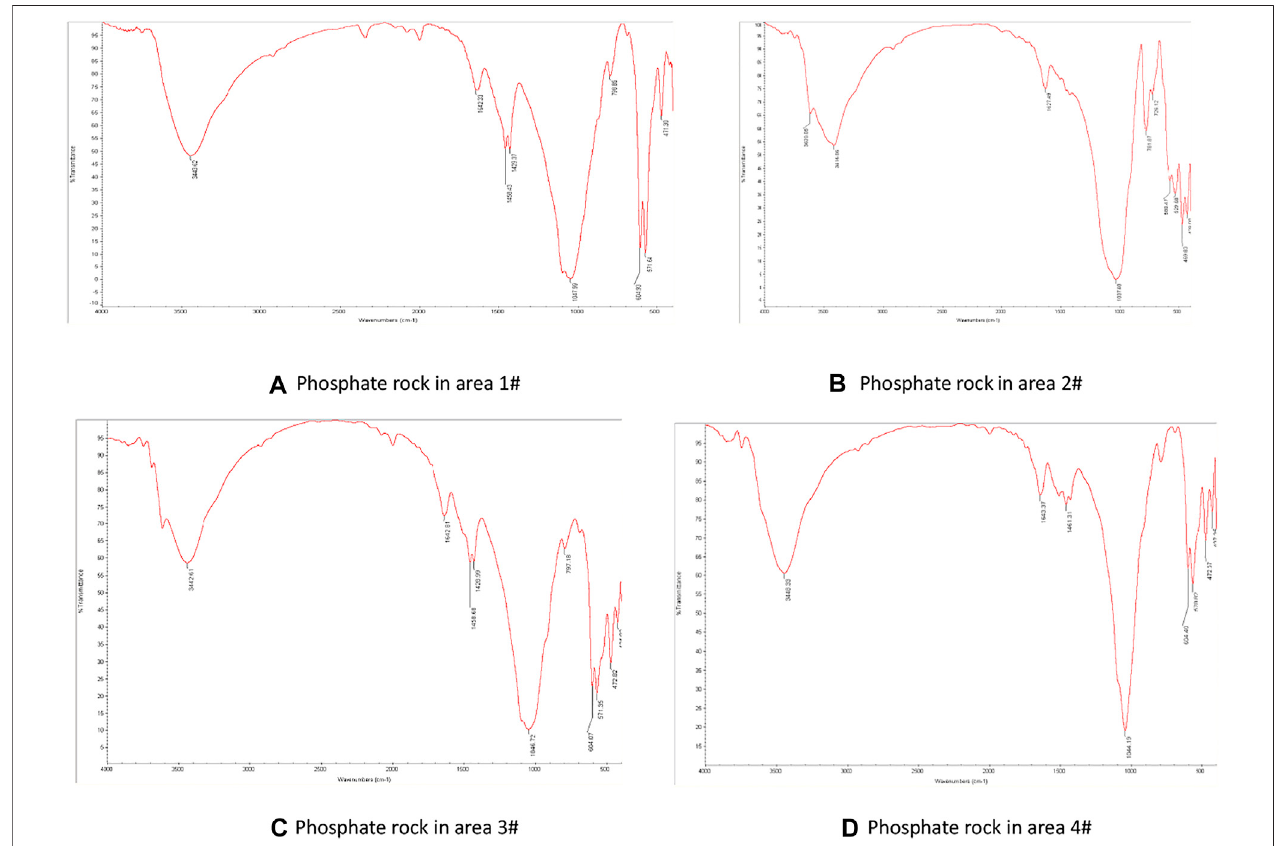
FIGURE 2 | Infrared spectrum of phosphate rock specimens. (A) Phosphate rock in area 1#, (B) Phosphate rock area 2#, (C) Phosphate rock in area 3#, (D) Phosphate rock in area 4#.